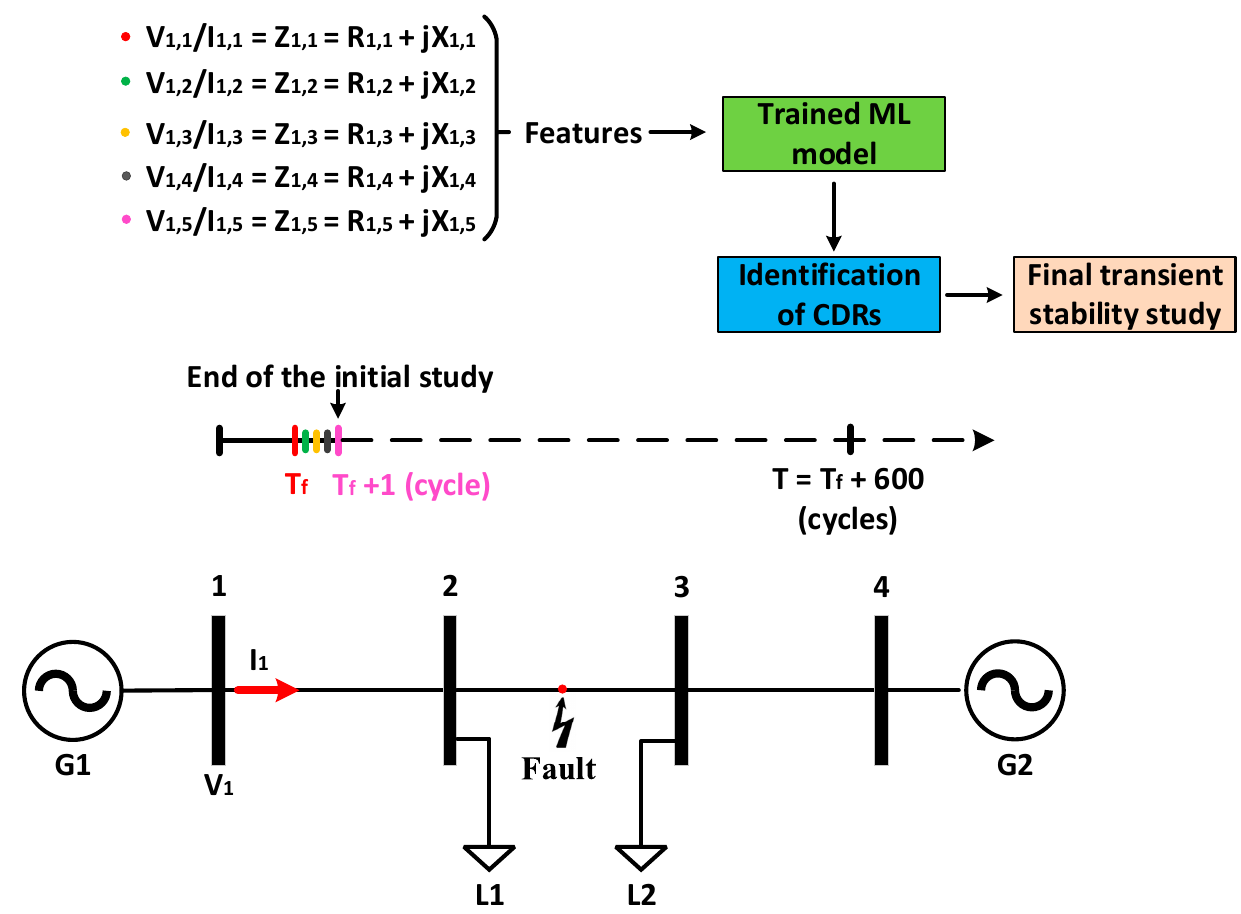
Figure 3. Conceptual representation of the process for extracting the required features of the trained RF model at the application phase.